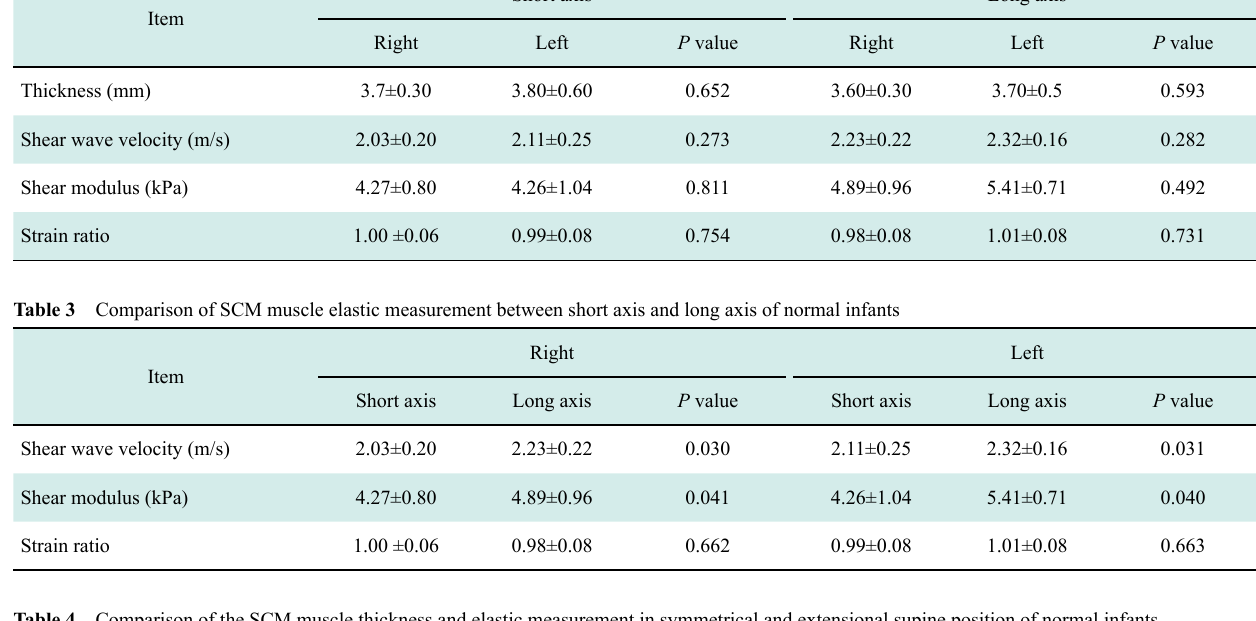
Table 4 Comparison of the SCM muscle thickness and elastic measurement in symmetrical and extensional supine position of normal infants